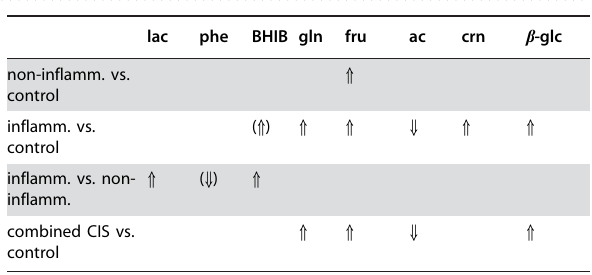
lac phe BHIB gln fru ac crn b -glc X non-inflamm. vs. control inflamm. vs. control inflamm. vs. non- inflamm. Y X combined CIS vs. control Upward (downward) arrows indicate significantly increased (decreased) CSF metabolite concentrations [mM] for CIS groups. The significance threshold was set to p , 0.05. Parametric multiple-comparison tests (Fisher’s PLSD) and nonparametric Mann-Whitney U tests yielded consistent results with respect to between-group significance (see Table 3). The arrow in parentheses indicates a trend close to significance (0.05 , p , 0.10). Means 6 s.e.m. are given in Figure 1. Abbreviations: lac, lactate; phe, phenylalanine; BHIB, b -hydroxyisobutyrate; gln, glutamine; fru, fructose; ac, acetate; crn, creatinine; b -glc, b -glucose.